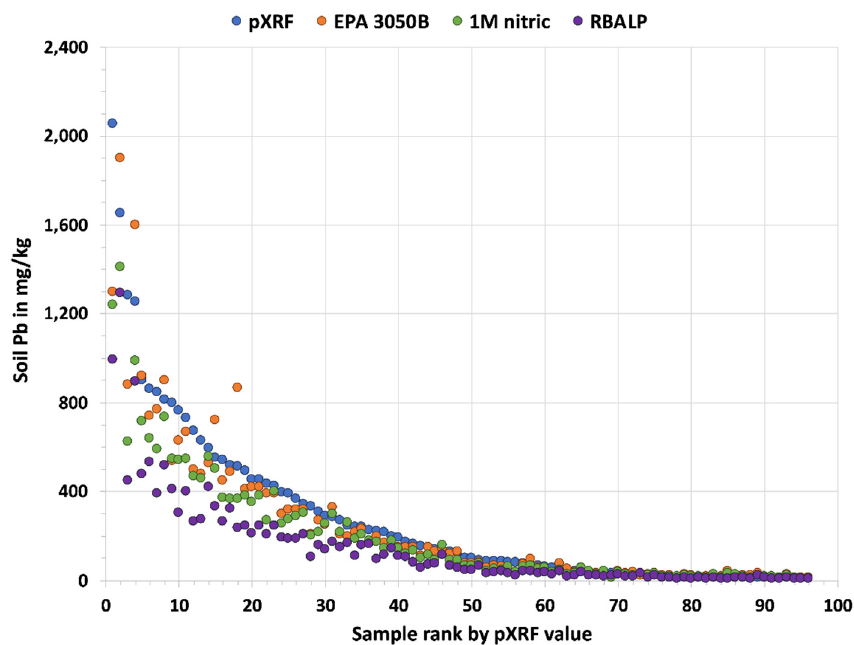
Figure 1. The graph shows the soil Pb results for each soil sample (N = 96) ranked by pXRF value for the results from each of the analytical methods.